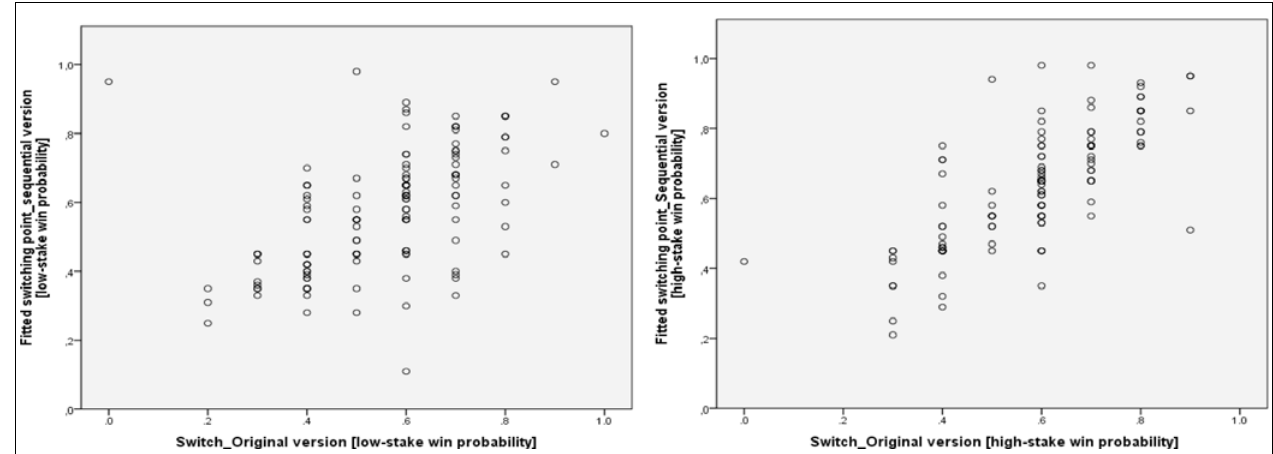
FIGURE 2 | Graphical comparisons of the switching points (from low to high risk choices) between the original lottery paradigm and the sequential version. In the original version, which provides the entire information of all lottery draws, no switch-backs were allowed.